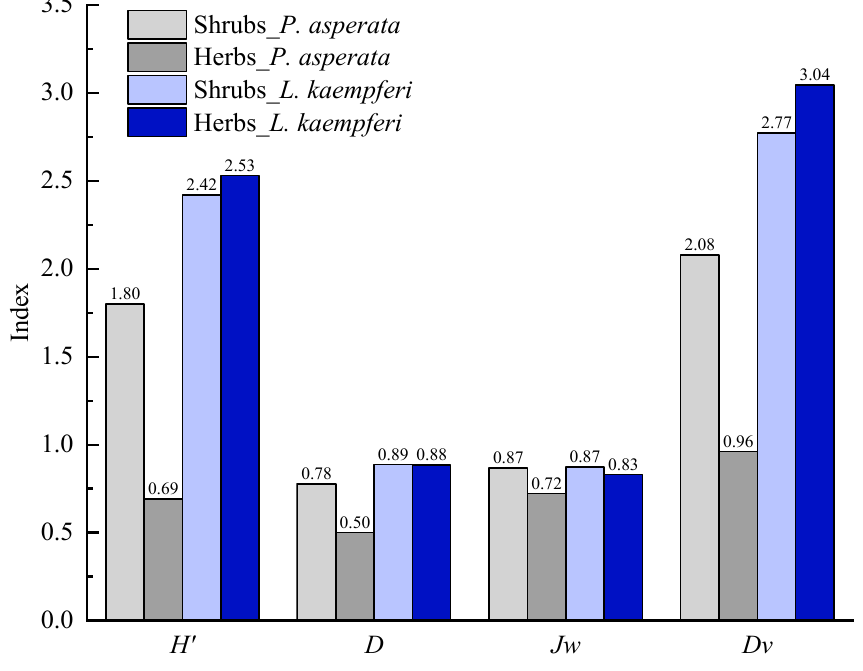
Figure 3. Alpha diversity of the shrubs and herbs